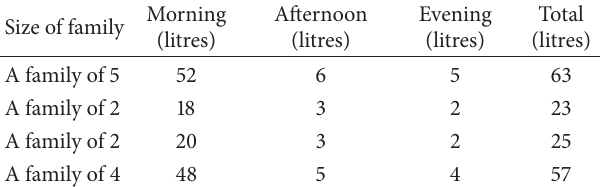
Figure 3: The solar water heating system with the stand.